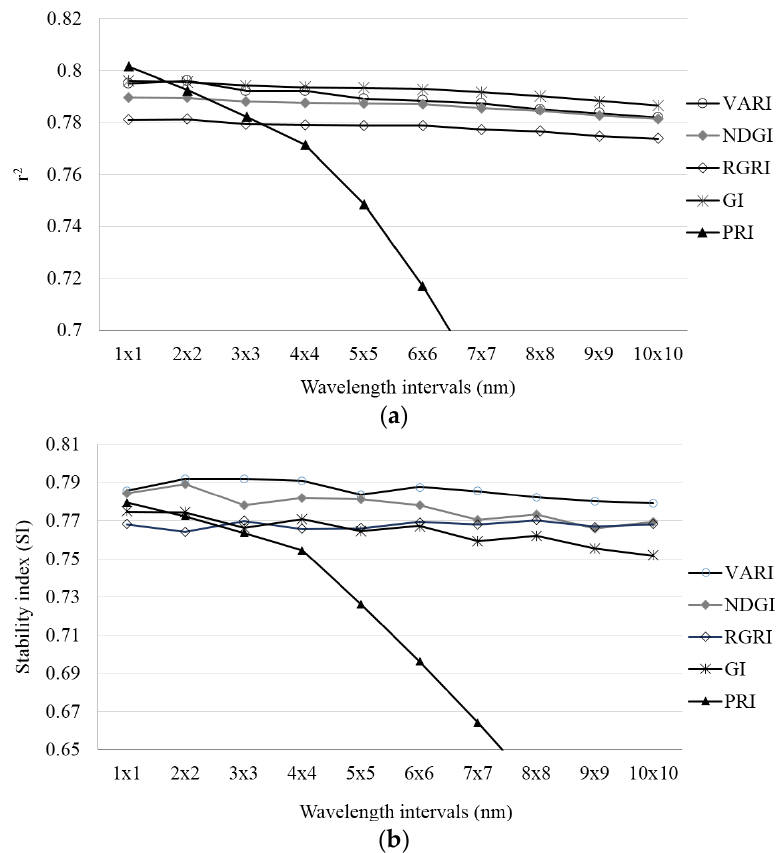
Figure 5. Impact of different wavelength intervals of 1 nm (1 × 1), 2 nm (2 × 2), …, 10 nm (10 × 10) on ( a ) the best squared Pearson correlation coefficient (r 2 ) relating the measured Ψ pd and the VIs obtained with the optimized formulation; and ( b ) the respective stability index